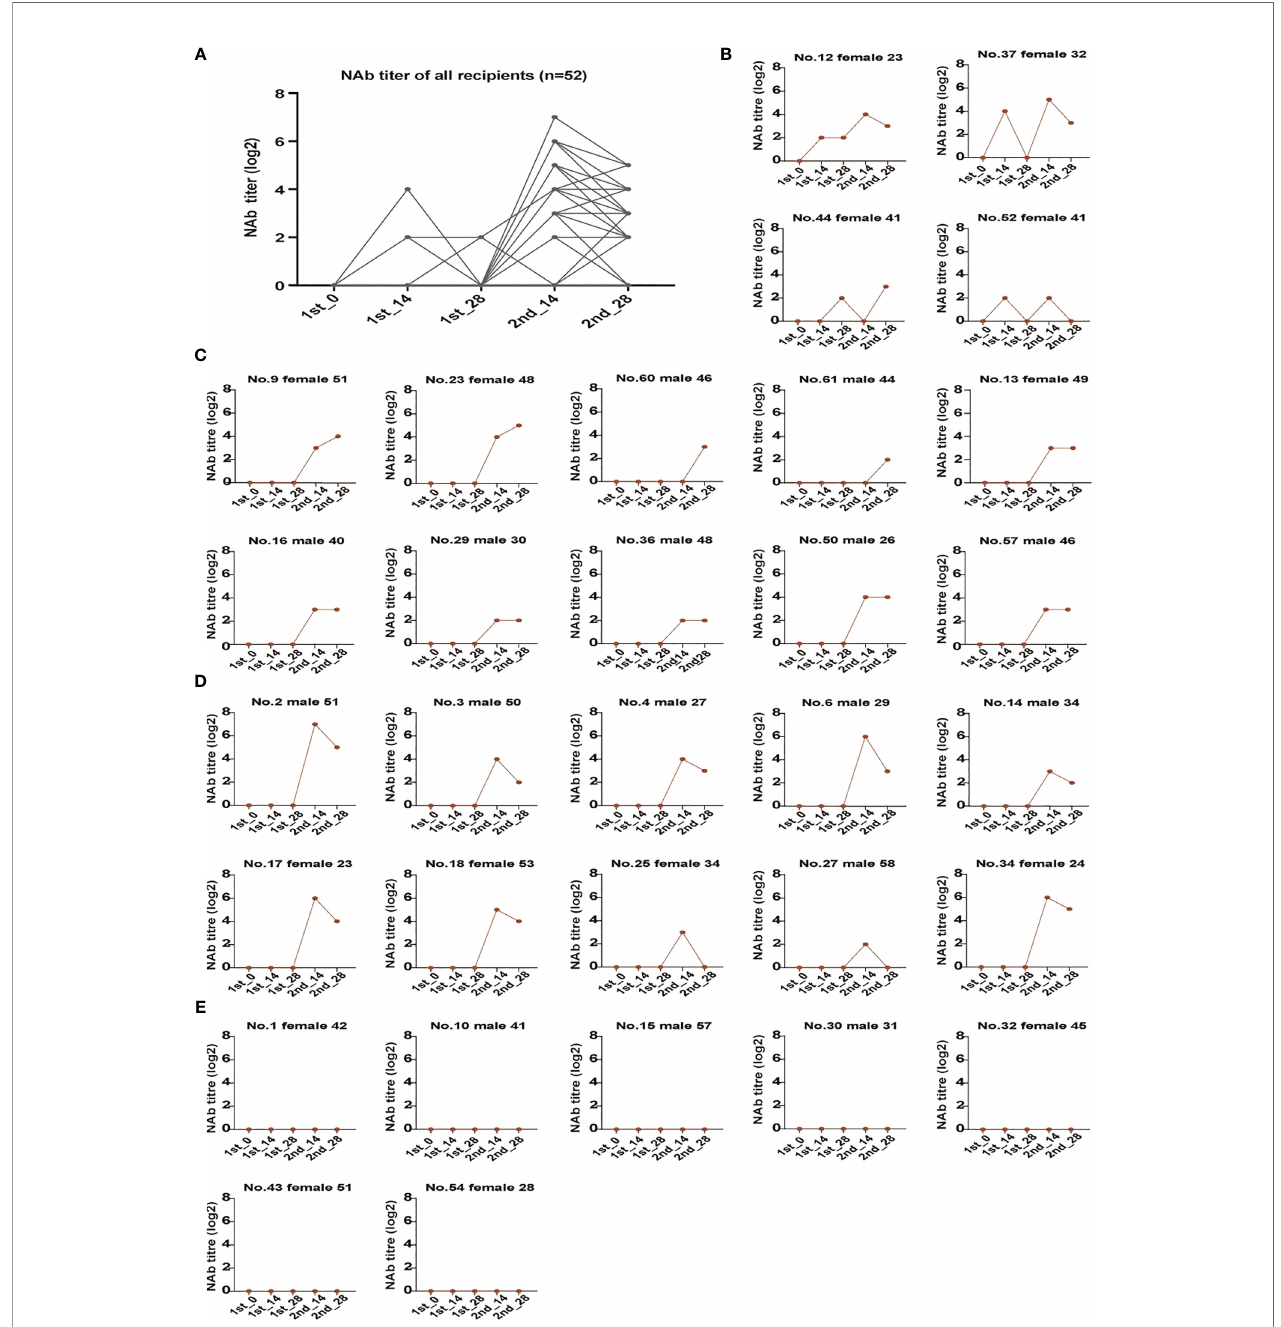
FIGURE 3 | The longitudinal dynamics of the anti-SARS-CoV-2 neutralizing antibody response during the vaccination course. (A) Dynamic changes in anti-SARS- CoV-2 NAbs of all recipients (n=52). (B) Recipients with an M-shaped dynamic curve of NAb titer levels (n=4). (C) Recipients with a slide-shaped dynamic curve of NAb titer levels (n=10). (D) Partial recipients with a bell-shaped dynamic curve of NAb titer levels (n=31). (E) Recipients with a straight line shape dynamic curve of NAb titer levels (n=7). NAb, anti-SARS-CoV-2 neutralizing